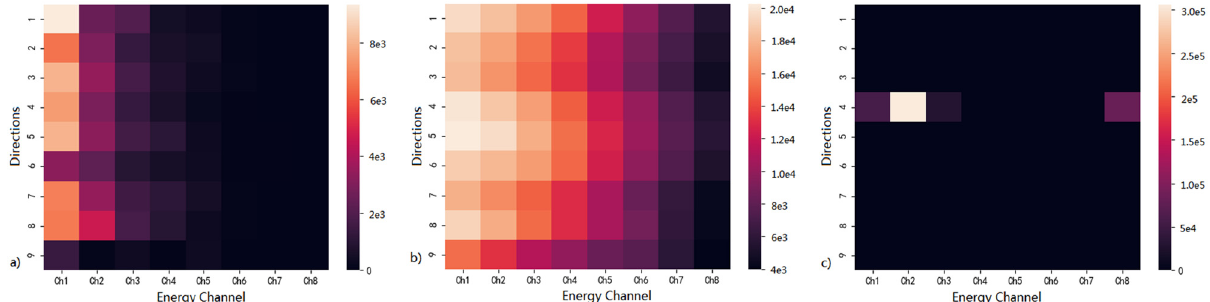
Figure 5: The data characteristics of detection data and outliers. ( a ) Characteristics in peace time; ( b ) characteristics in storm time; and ( c ) characteristics of